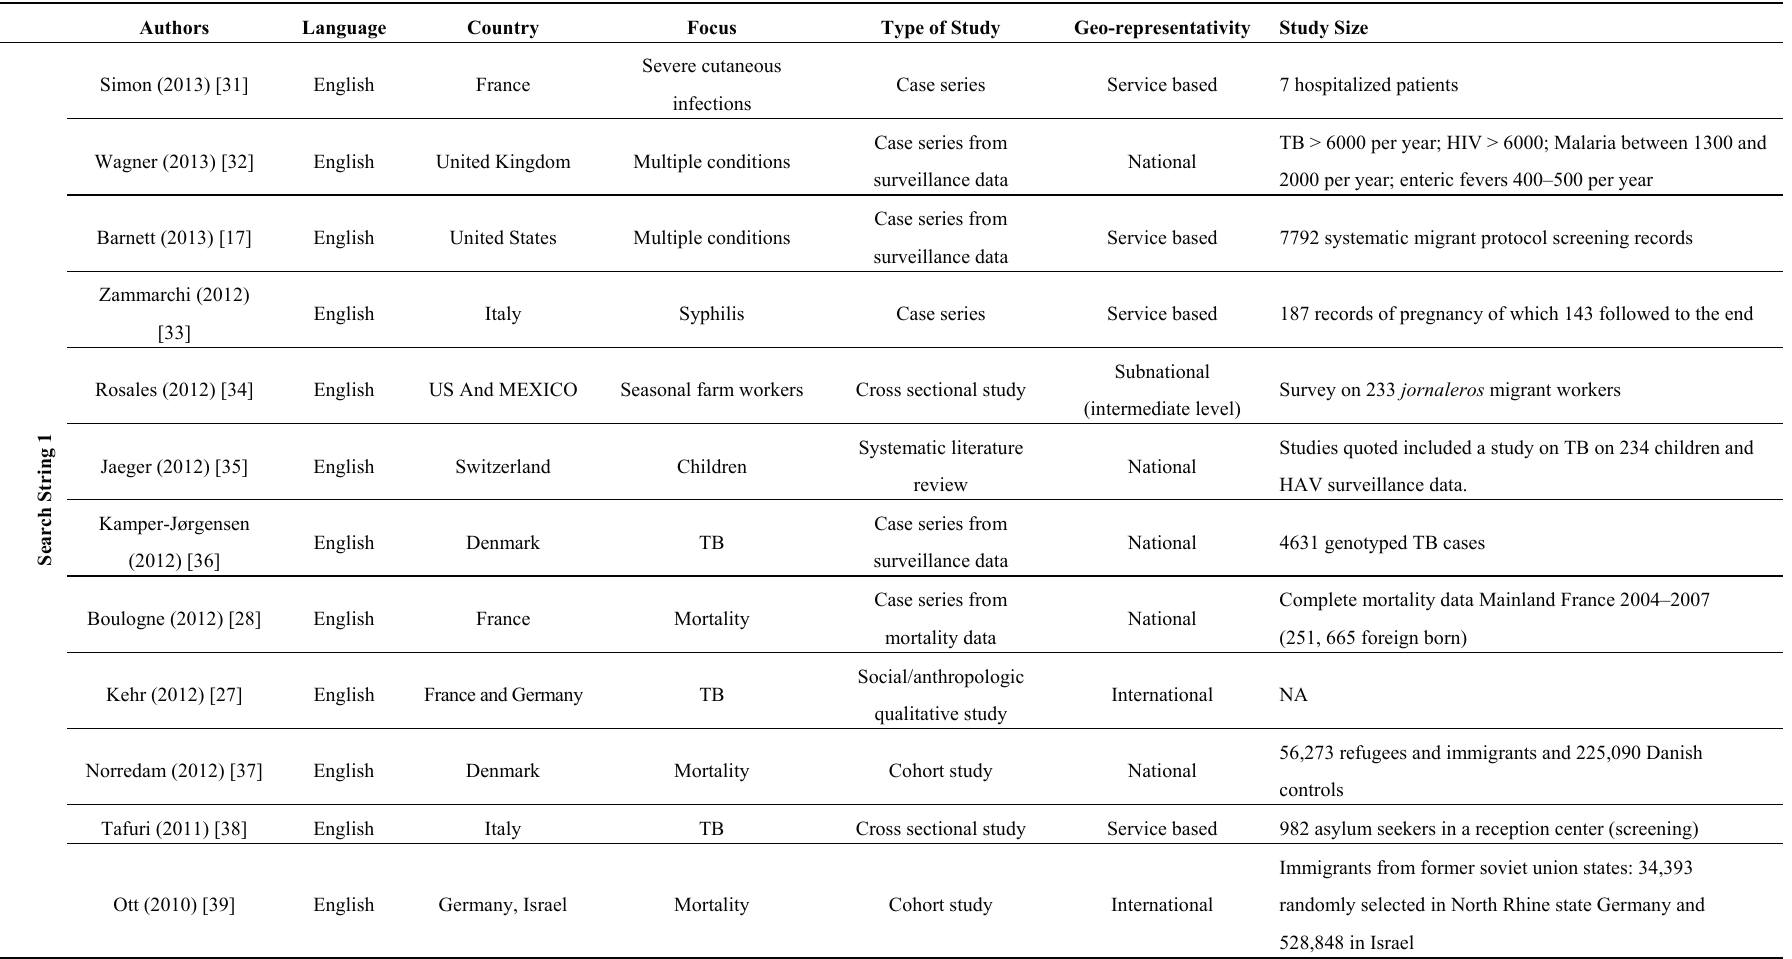
Table 2. Studies included in the systematic review (25 studies in 26 published